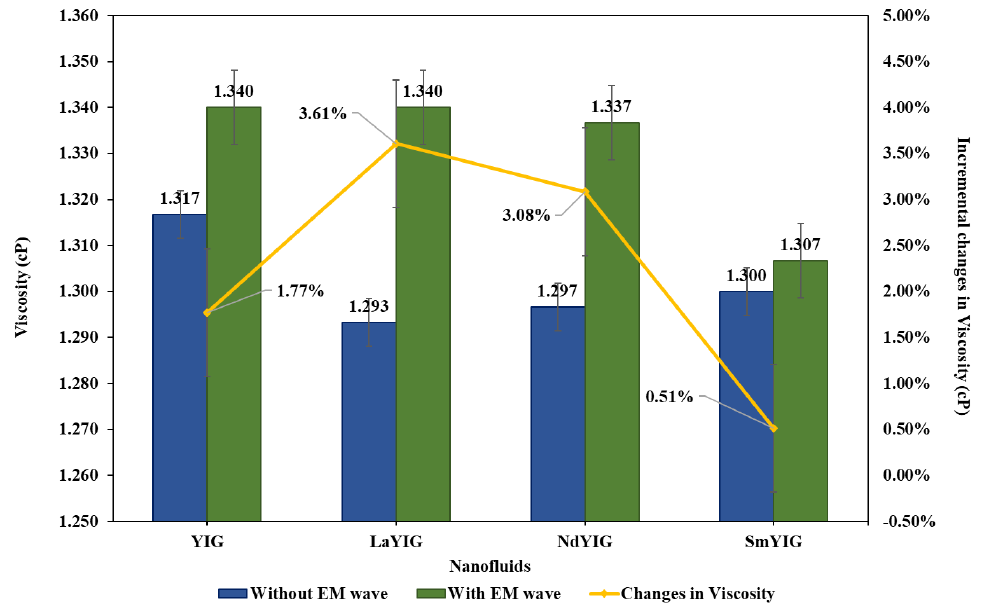
Figure 7. Viscosity for RE-YIG samples with and without EM waves.